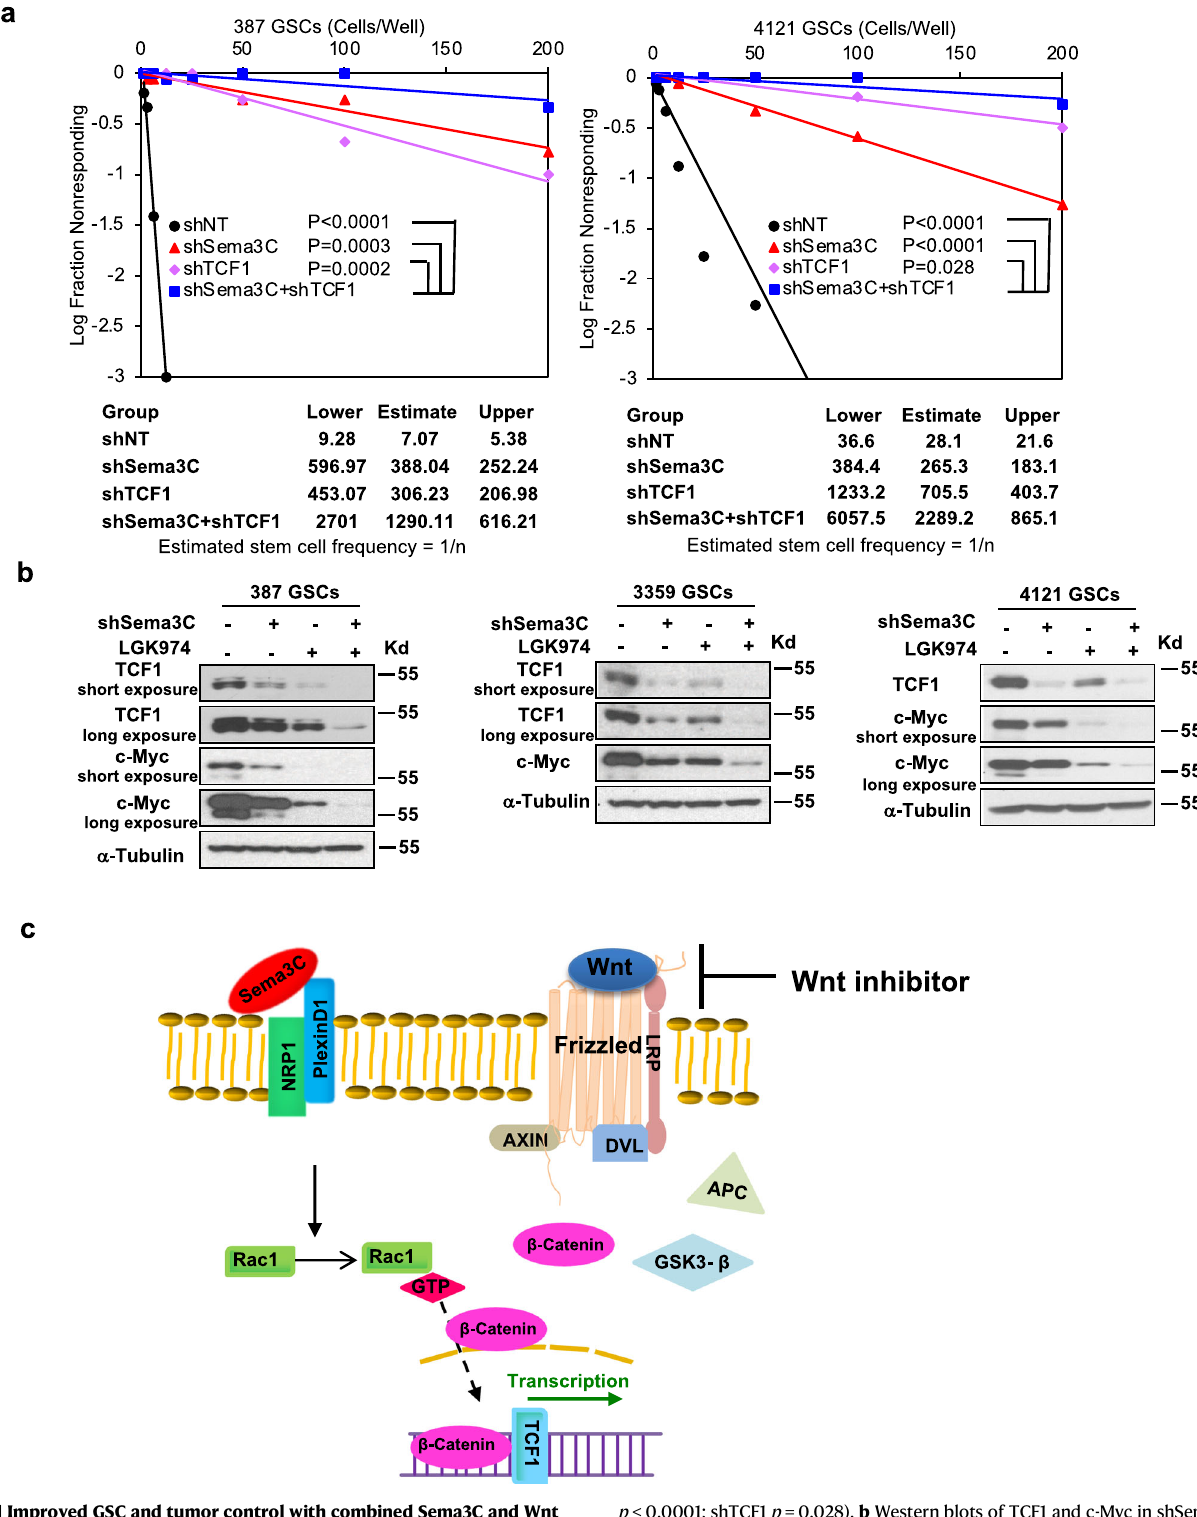
p <0.0001; shTCF1 p =0.028). b Western blots of TCF1 and c-Myc in shSema3C knockdownGSCstreatedwithLGK974100 μ Morvehiclecontrolfor24h.Western blots were repeated at least twice. c Model of Sema3C regulation of the Wnt pathway in GSCs. Despite upstream Wnt pathway inhibition, Sema3C binds to the Neuropilin 1 (NRP1) — PlexinD1 receptor complex pathway to activate Rac1. Active Rac1(Rac1-GTP)facilitates β -cateninnucleartranslocationtodriveWnttargetgene transcription. Source data are provided as a Source data fi